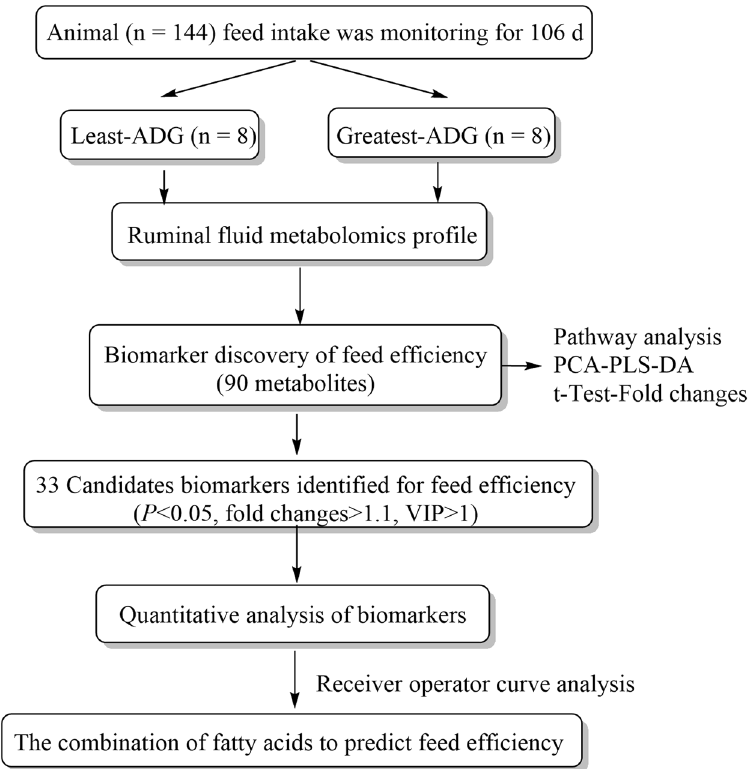
Figure 5. Overview of workflow utilized in the identification of biomarkers of feed efficiency on crossbreed